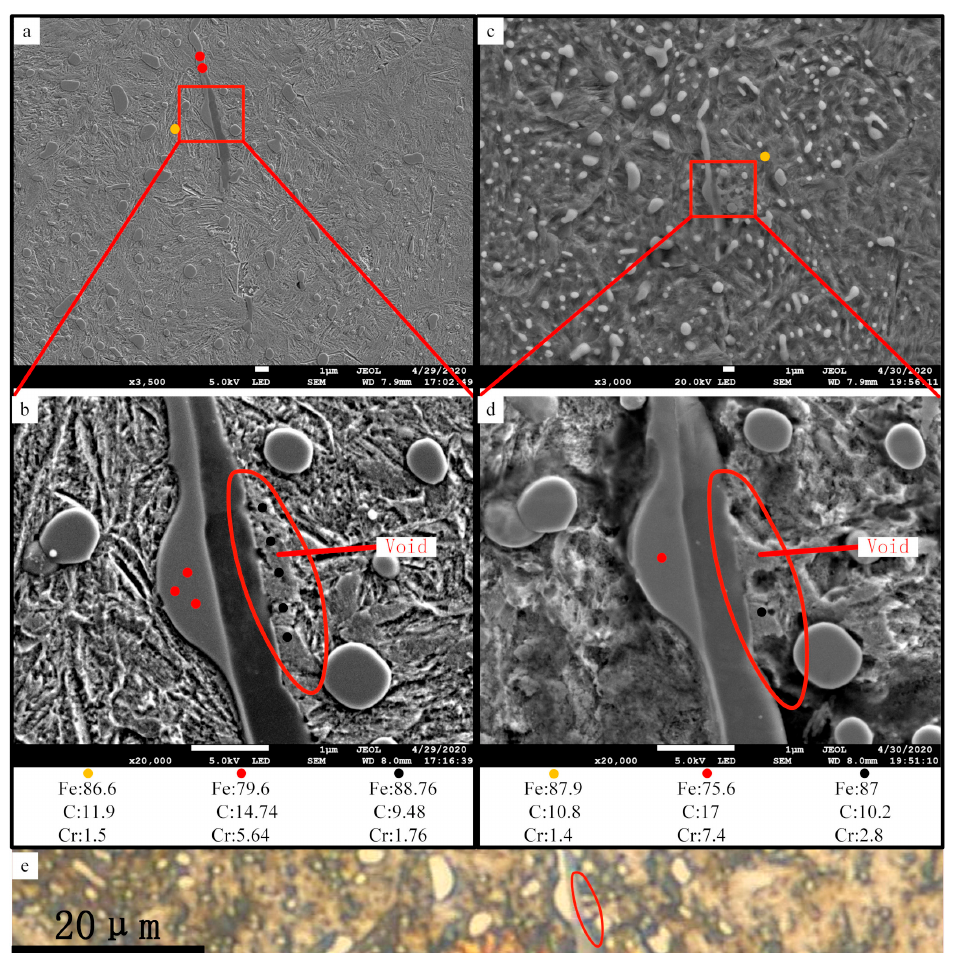
Figure 11. White etching area (WEA) adjacent to the inclusion observed in 0.3 mm section of the plate specimen. ( a ) Slightly etched micrograph of 05# inclusion; ( b ) detail view of (a) with EDS results; ( c ) deep etched micrograph of 05# inclusion; ( d ) detail view of (c) with EDS results; ( e ) optical micrograph of 05# inclusion after deep etching. The dots with different colours represent the detection position of EDS. Red is carbide, black is the WEA area, and yellow is the martensite matrix. Position of the inclusion is shown in Figure 10.